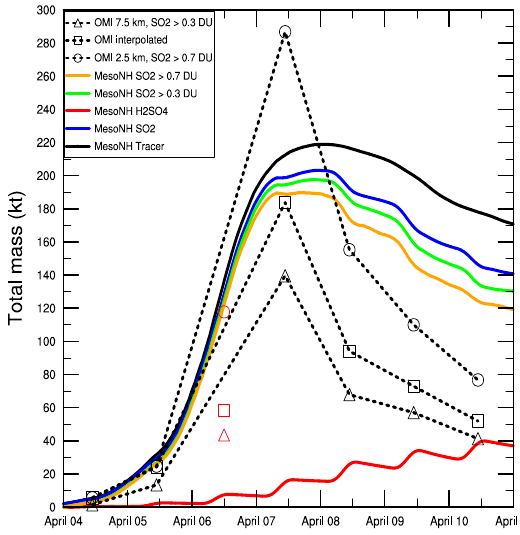
Fig.8. Sumofthemass(kt)simulatedbyMesoNHonthewholedomain(solidlines)andobservedbyOMI(dashedlineswithtriangles, Fig. 8. Sum of the mass (kt) simulated by MesoNH on the whole squaresandcircles)betweenApril4andApril11,2007.Black,blue,green,yellowandredsolidlinescorrespondtothepassivetracer,the SO 2 ,theSO 2 wherethemassburdenishigherthan0.3DU,theSO 2 wherethemassburdenmassishigherthan0.7DU,andtheH 2 SO 4 , domain (solid lines) and observed by OMI (dashed lines with tri- respectively. Blacktriangles,circlesandsquarescorrespondtotheOMItotalmassgivenbyTRM,TRLandweightedbetweenTRLand TRM,respectively.Redtriangles,circlesandsquaresrepresentunderestimatedOMIvalues. angles, squares and circles) between 4 April and 11 April 2007. Black, blue, green, yellow and red solid lines correspond to the passive tracer, the SO 2 , the SO 2 where the mass burden is higher than 0.3DU, the SO 2 where the mass burden mass is higher than 0.7DU, and the H 2 SO 4 , respectively. Black triangles, circles and squares correspond to the OMI total mass given by TRM, TRL and weighted between TRL and TRM, respectively. Red triangles, cir- cles and squares represent underestimated OMI